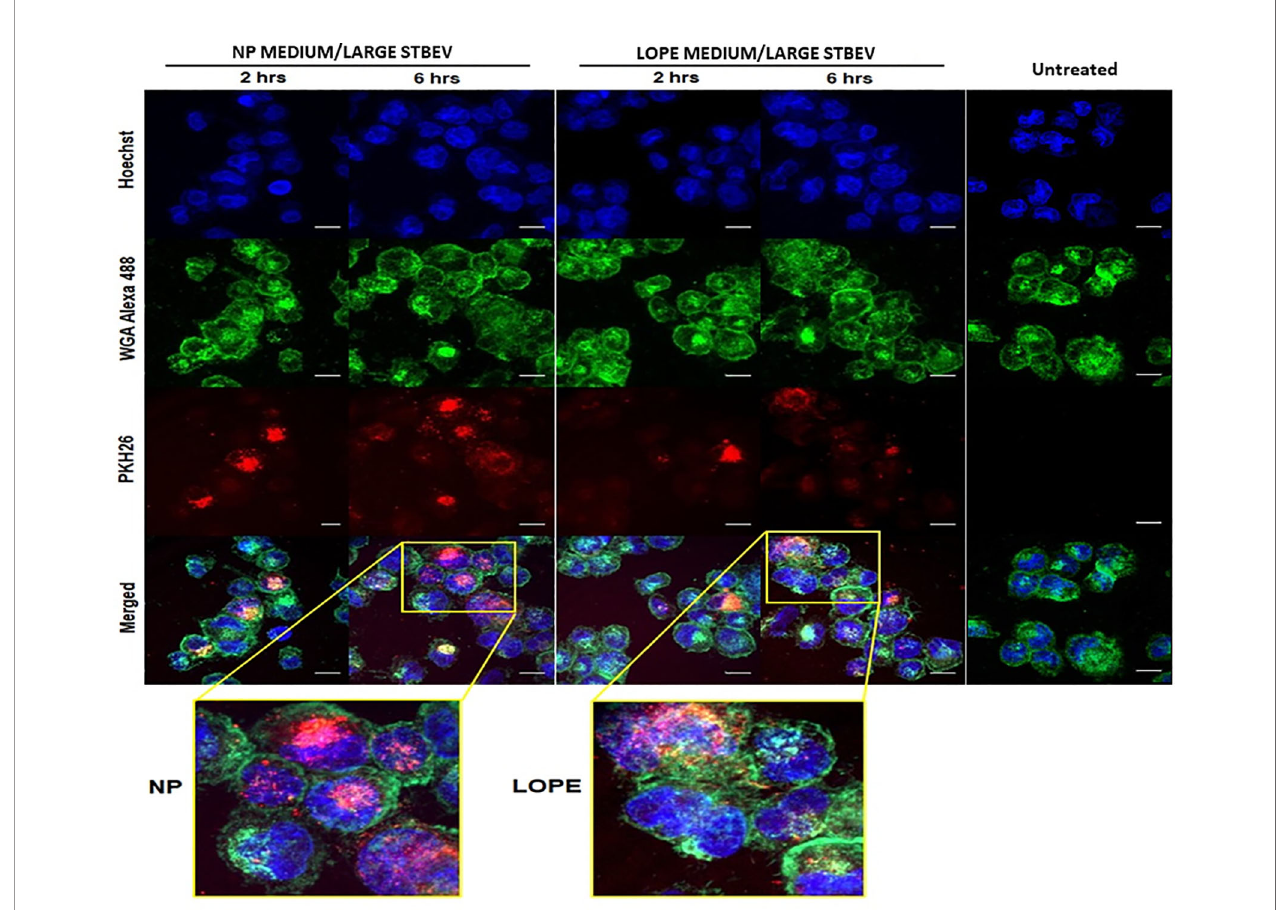
FIGURE 4 | The internalisation of medium/large STBEVs from NP and PE placentae into THP-1 cells by confocal microscopy (technical replicate =3). Medium/large STBEVs derived from NP and PE patients incubated for 2 and 6 hours incubation with differentiated THP-1 cells. Channels panel show cells ’ nuclei labelled with Hoechst dye (blue), cells ’ membrane labelled with WGA Alexa 488 (green), STBEVs labelled with PKH26 dye (red) and merged channels. ThP-1 only incubated with no STBEVs are used as the control. This control also served as the control for the experiment to detect internalisation of small STBEVs from NP and PE placentae into THP-1 cells ( Figure 5 ). Scale bars, 10 m